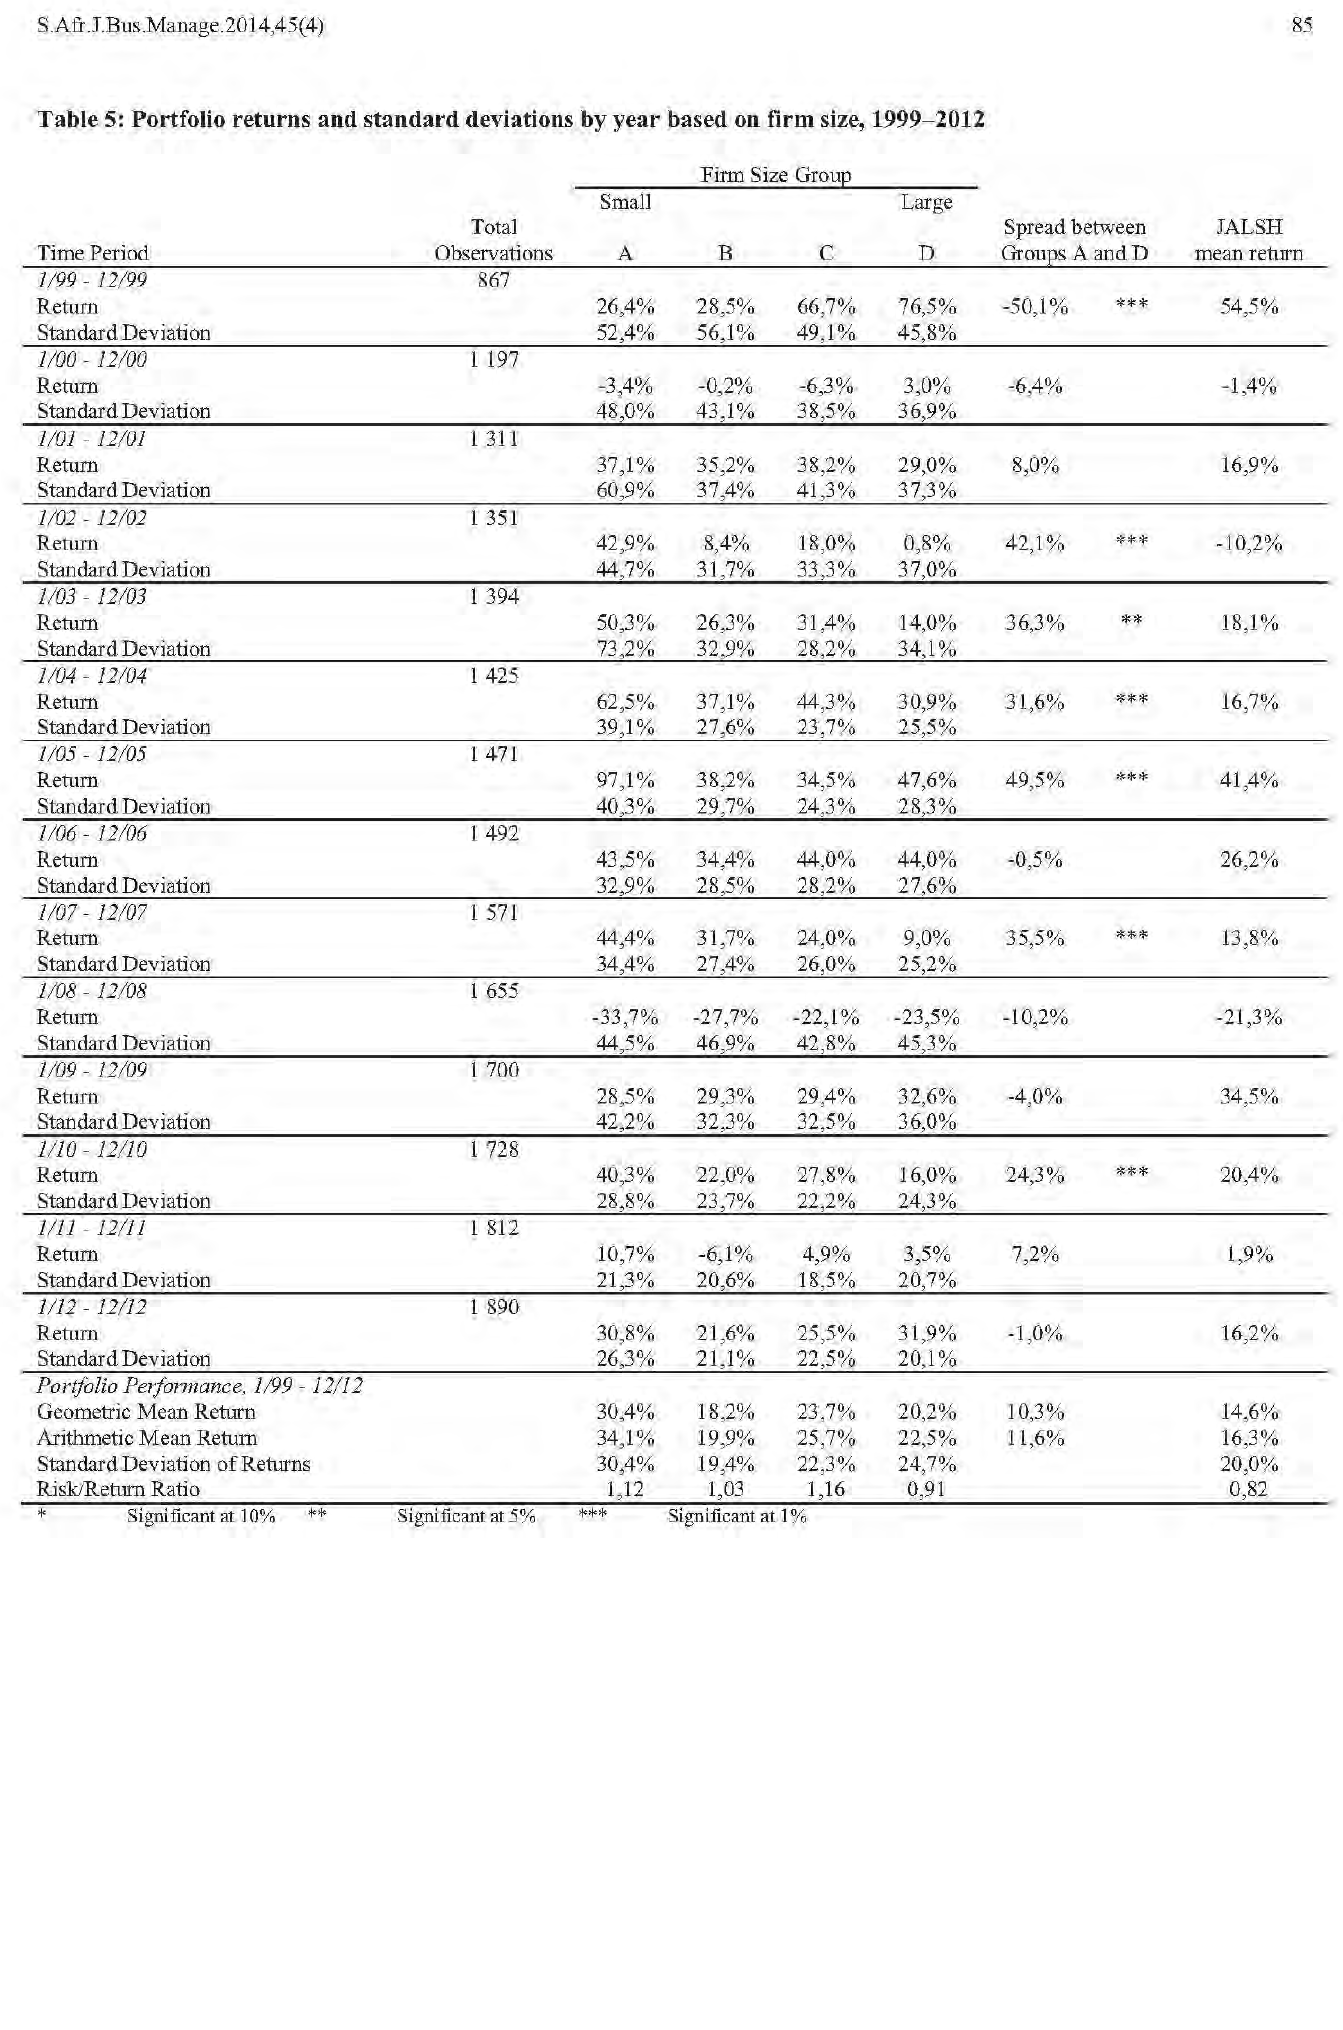
Table 5: Portfolio returns and standard deviations by year based on firm size, 1999-2012